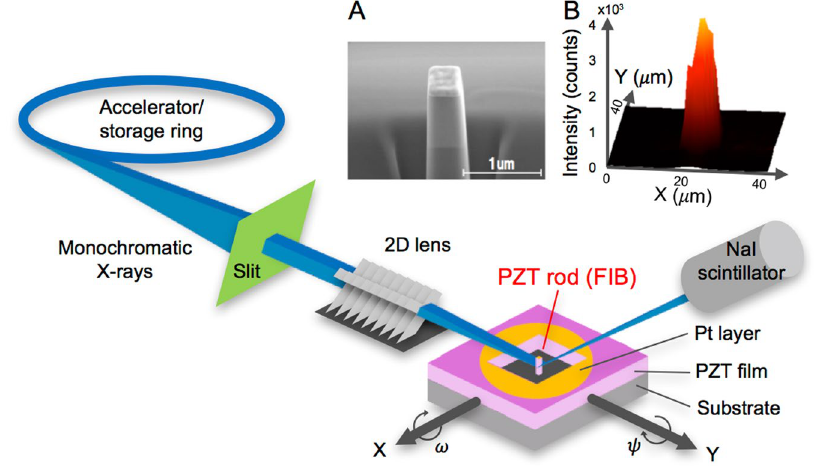
Figure 2. Schematic illustration of the set-up for synchrotron micro XRD build at BL13XU and BL15XU beamlines in SPring-8. X-ray beam was focused on a single rod fabricated by FIB. ( A ) shows a SEM image for 500 nm-wide rod, and ( B ) shows X-Y mapping for PZT (003) of 1 μ m-wide rod, as typical examples.